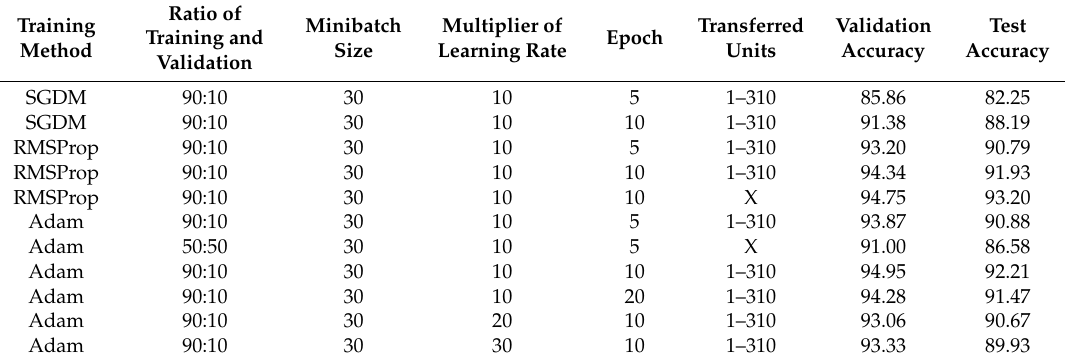
Table 9. Performance of ResNet on